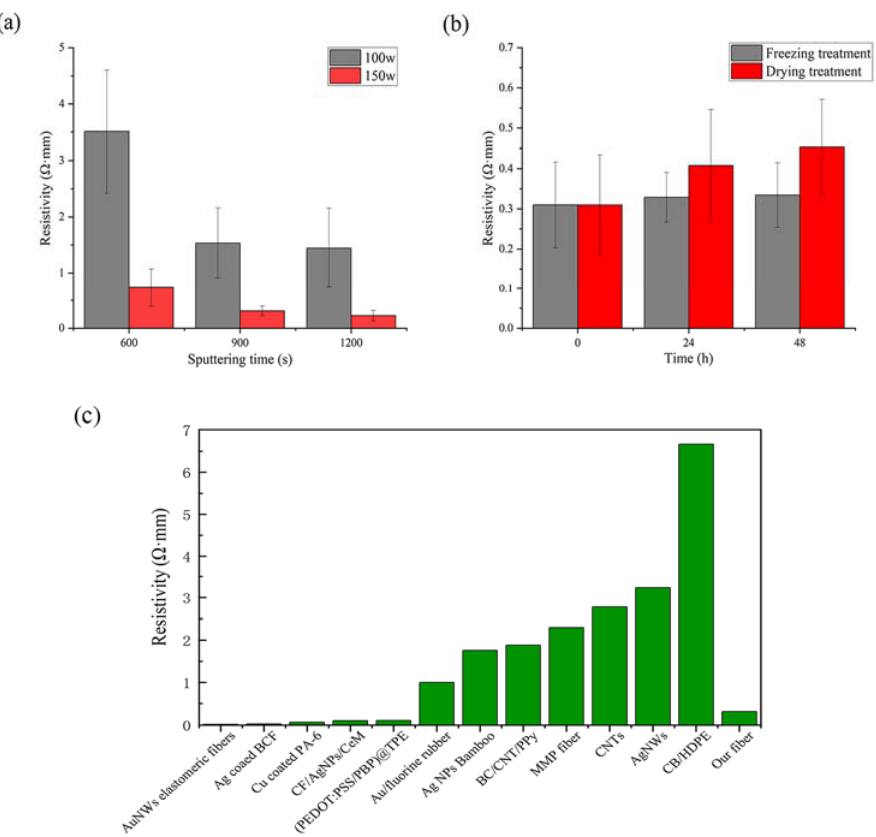
Figure 2. ( a ) Resistivity of conductive bamboo fiber bundle under different process parameters. ( b ) Resistivity of conductive bamboo fiber under different ambient temperatures. ( c ) Comparison of the resistivity of the conductive bamboo fiber bundle with other conductive